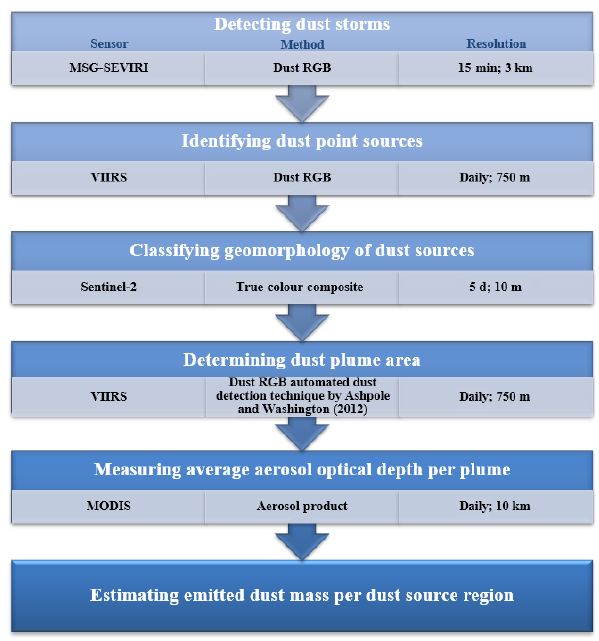
Figure 1. Overview of the methodology of the study. The remote sensing sensor used in each step is presented in the left column, the image processing method employed is shown in the middle column, and the resolution (temporal; spatial) is shown in the right